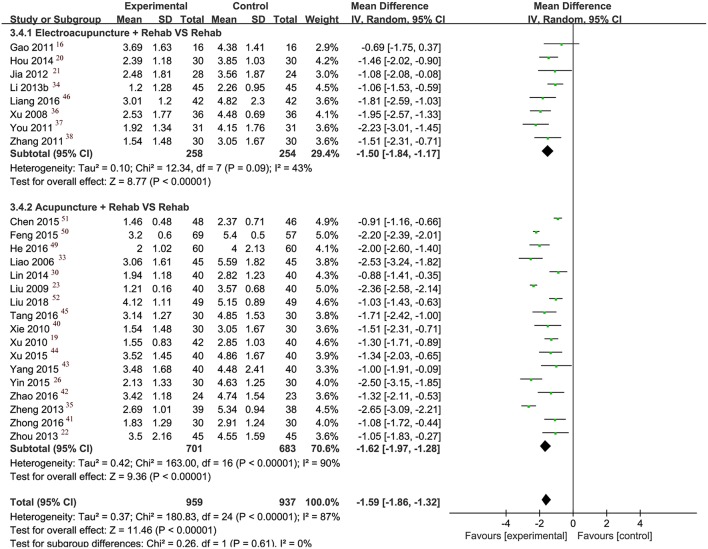
Forest plot of VAS.